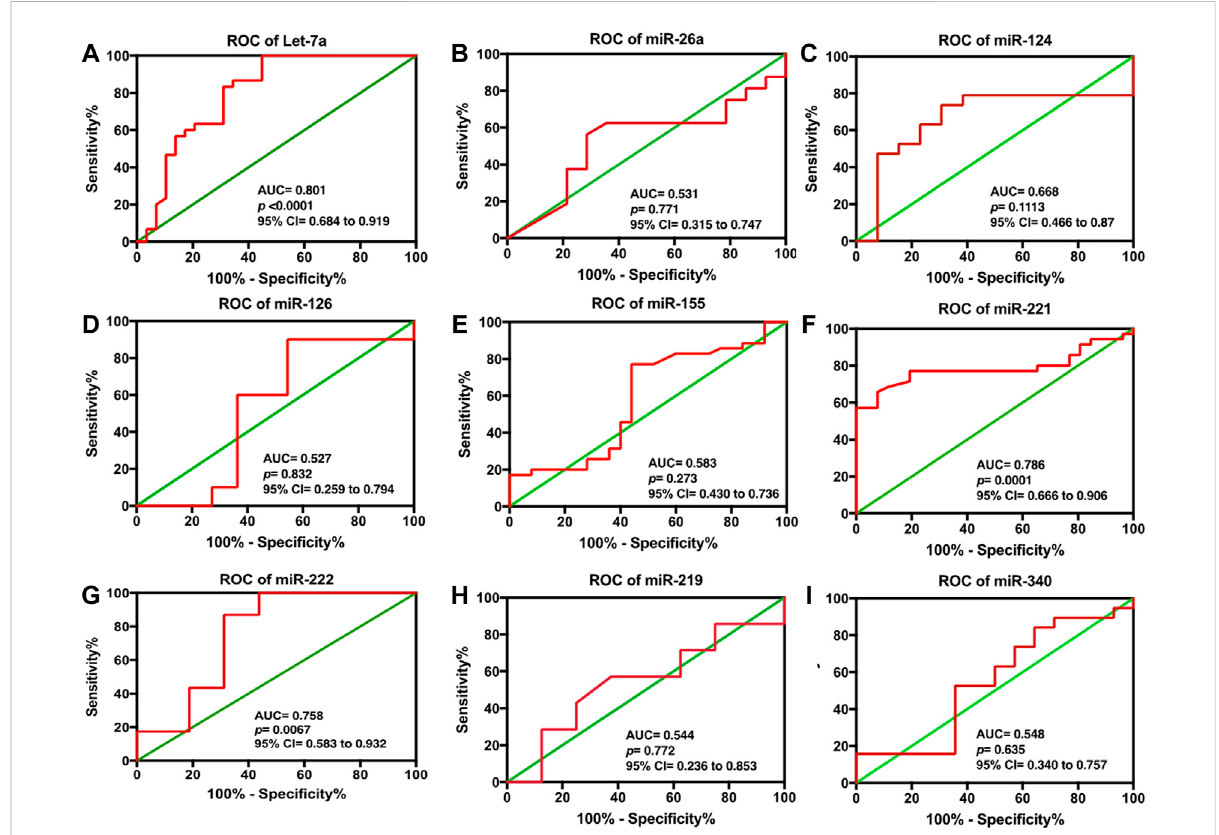
FIGURE 3 ROC analysis for serum (A) Let-7a, (B) miR-26a, (C) miR-124, (D) miR-126, (E) miR-155, (F) miR-221, (G) miR-222, (H) miR-219, and (I) miR-340 in HCC patients. The statistical analysis was done using GraphPad Prism 5.0.